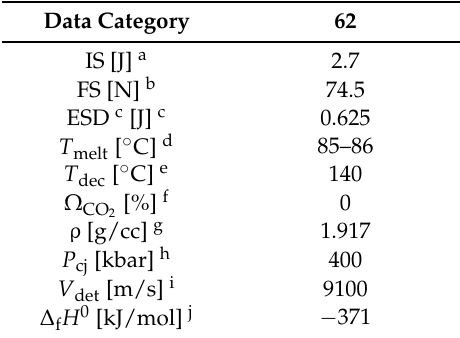
Table 8. Performance and sensitivities of tetranitrate ester 62.